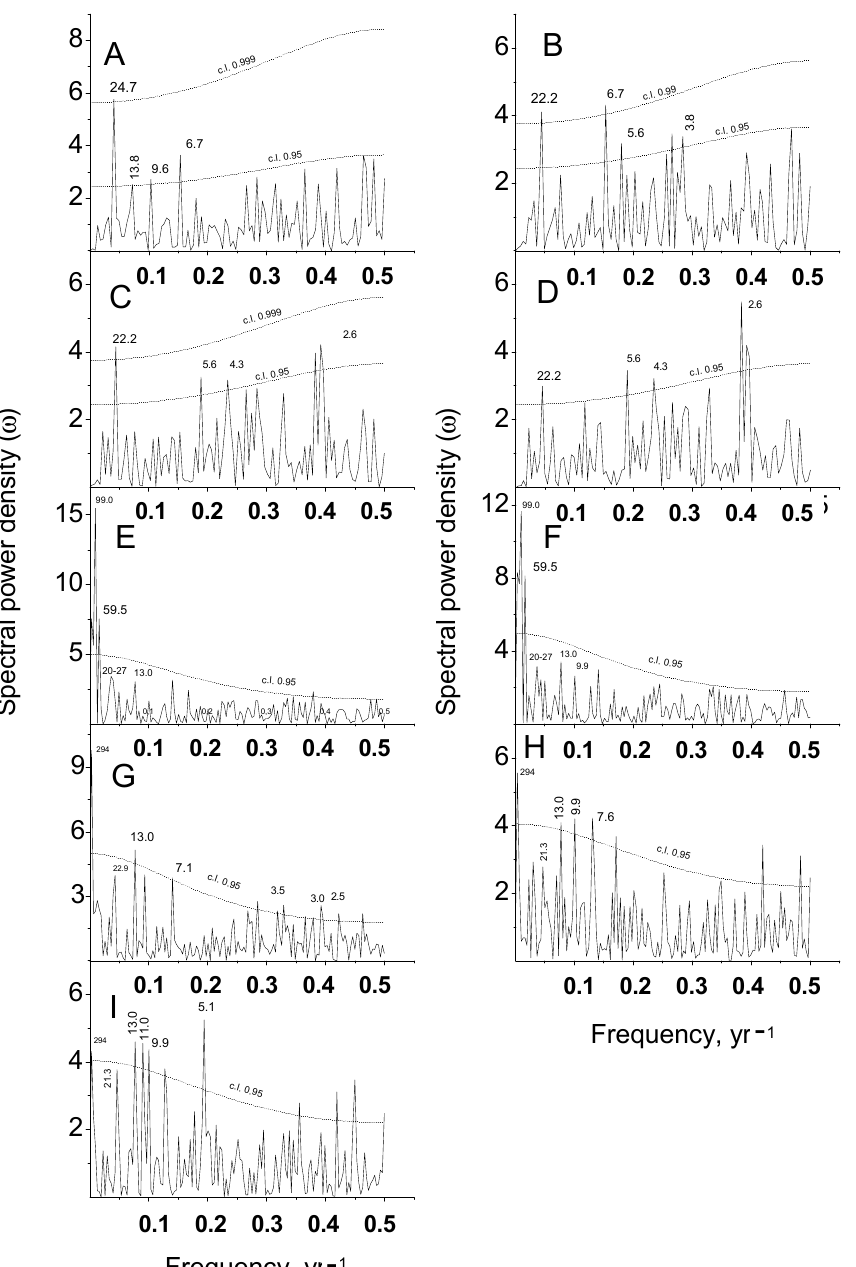
Figure 1. Fourier spectra of temperature reconstructions at: ( A ) (55 ◦ N, 10 ◦ E) gridpoint [11]; ( B ) (60 ◦ N, 10 ◦ E) gridpoint [11]; ( C ) (60 ◦ N, 20 ◦ E) gridpoint [11]; ( D ) (60 ◦ N, 30 ◦ E) gridpoint [11]; ( E ) Jämtland [13]; ( F ) West-Central Fennoscandia [12]; ( G ) Finnish Lakeland [14]; ( H ) Stockholm [15]; ( I ) Tallinn [16]. Dashed lines delineate confidence levels calculated for red and blue noises with AR(1) coefficient individual for each time series. Linear trends were subtracted prior to analyses.